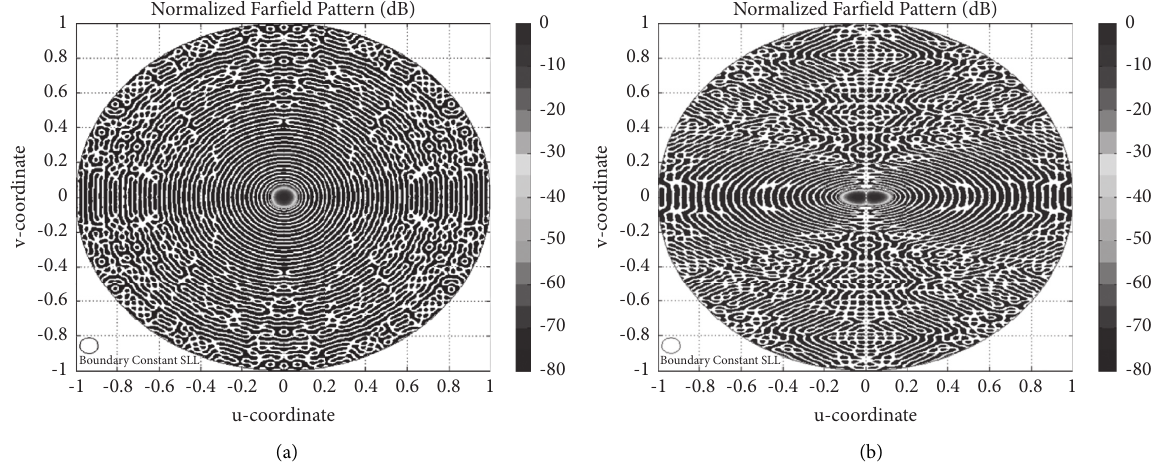
Figure 2: Pseudocontour plots [25]: (a) sum pattern of a 1.3m circular array with 5797 elements operating at 10GHz; (b) azimuth difference pattern of a 1.9m × 1.3m elliptical aperture with 5509 elements operating at 10GHz. Both patterns, obtained through amplitude-only IFT synthesis, feature a SLL of − 71dB. The array elements are arranged in a triangular